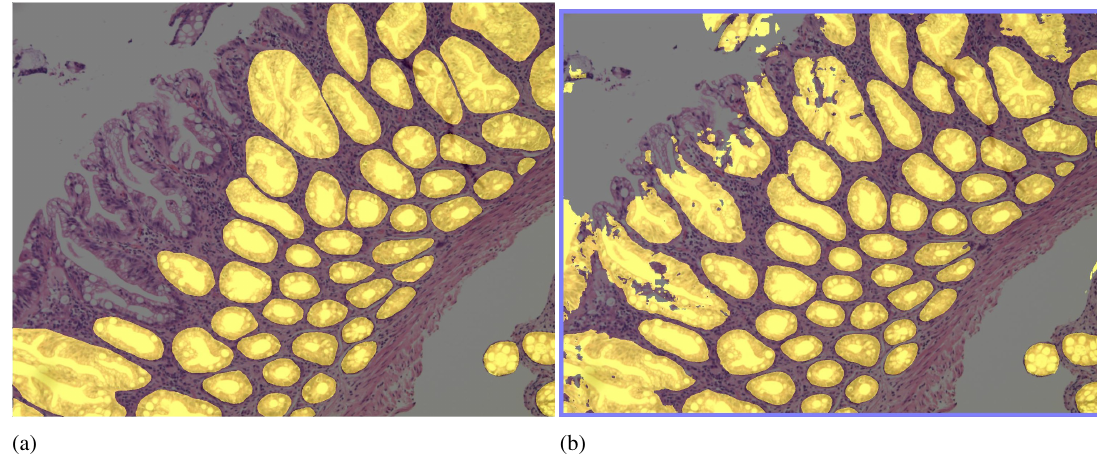
Figure 6. Results of the first phase of training on Warwick-QU dataset. Left to right: source image, ground truth glands, predicted glands.